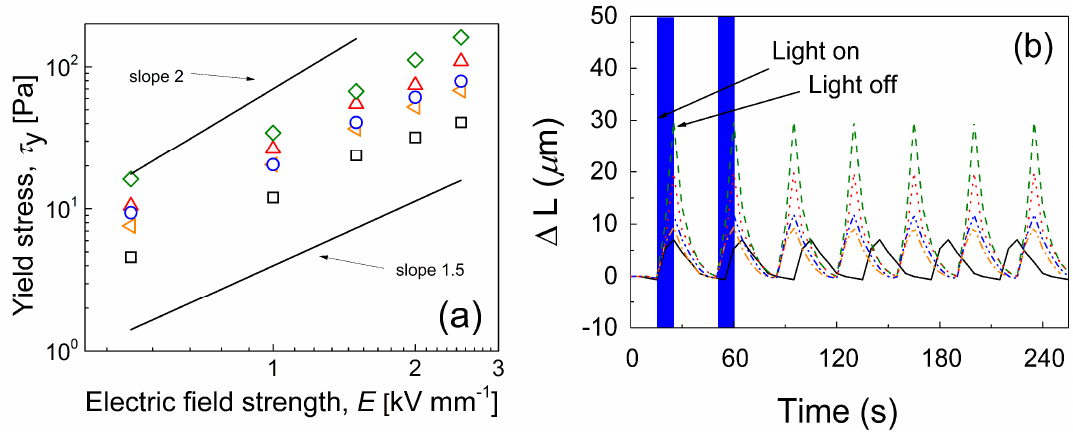
) and orange (cid:1)